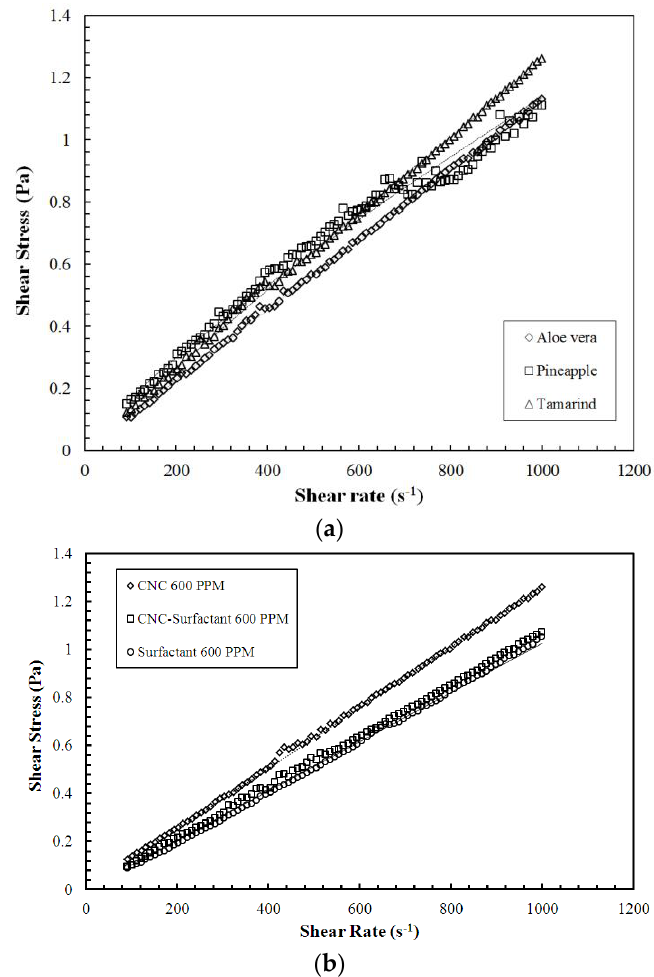
Figure 2. Shear Stress vs. Strain Rate for: ( a ) Polysaccharides; and ( b ) for CNC and CNC-Surfactant at 600 PPM. (The dotted line in ( a , b ) indicates the trendline using Power Law Fit). Viscosity obtained from the above-mentioned expressions was used to calculate the Re . In the case of the non-Newtonian fluid, average of the viscosity between Shear Rate of 200 and 1000 s − 1 was